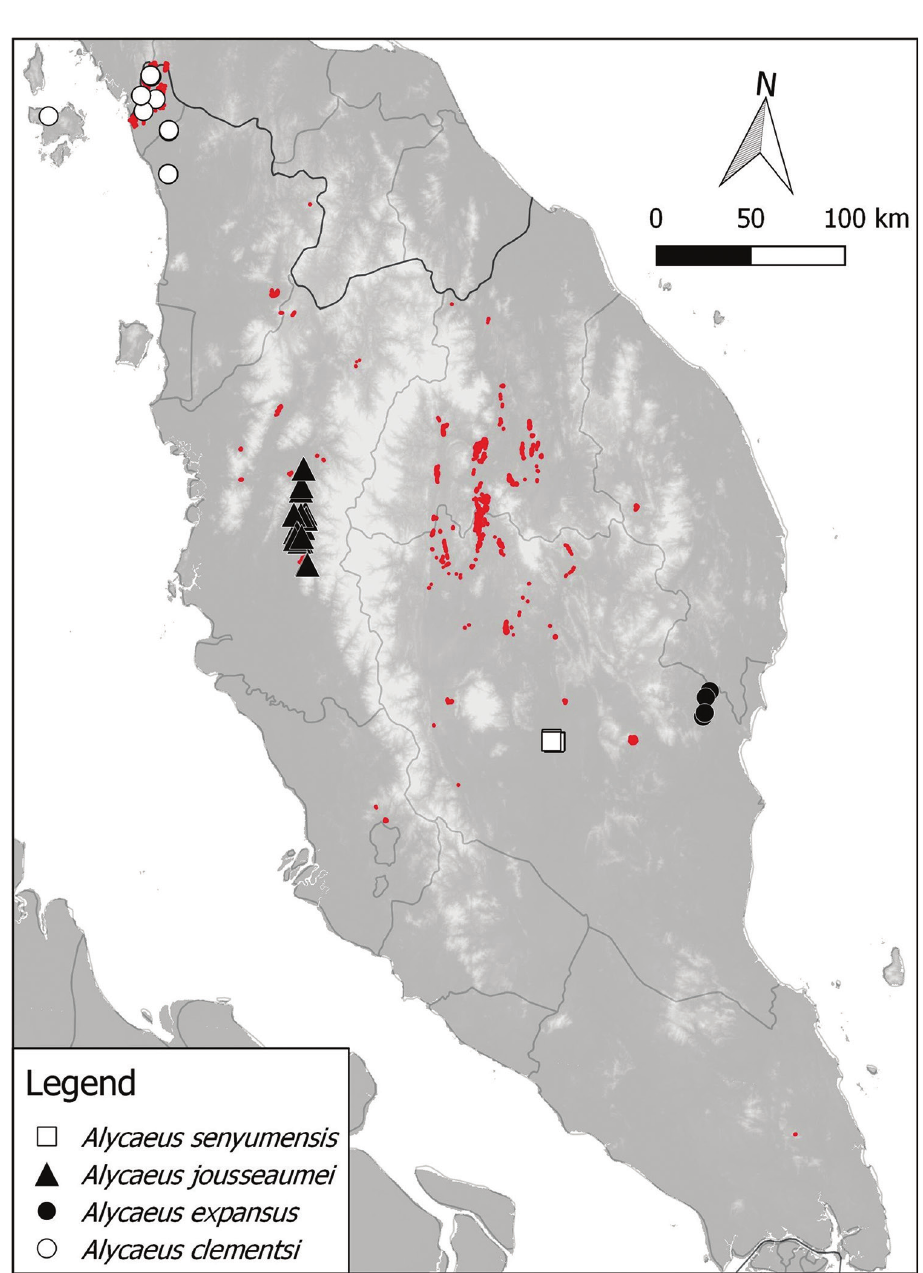
Figure 4. Distribution of 4 Alycaeus species in Peninsular Malaysia based on materials examined. Note the red areas are limestone karsts (derived from Liew et al.